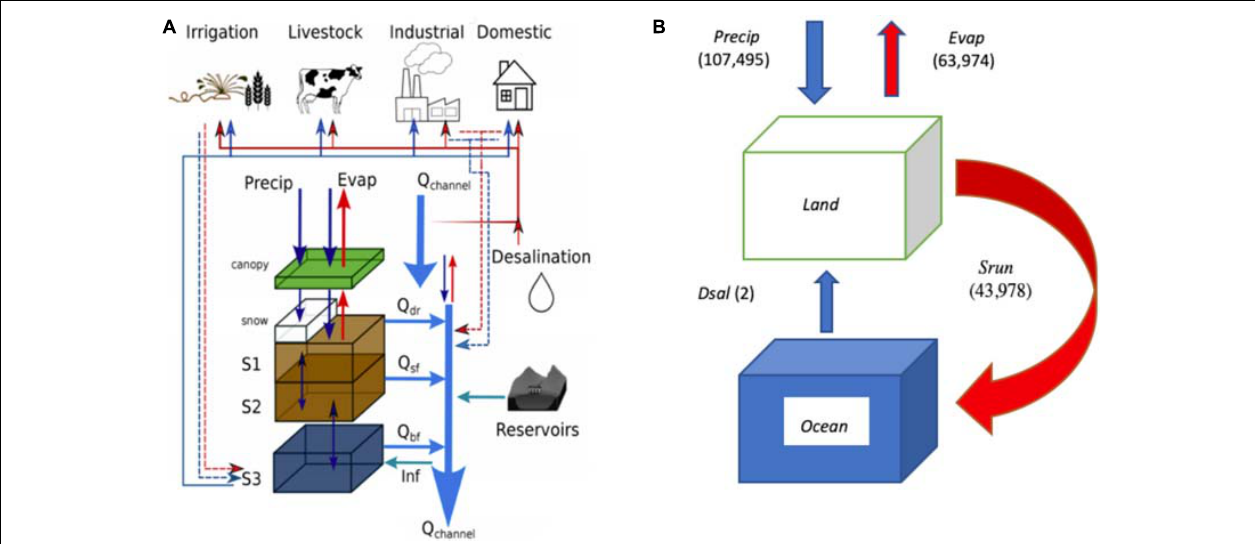
FIGURE 1 | (A) An overview of a PCR-GLOBWB 2 grid cell from Sutanudjaja et al. (2018). S1, S2 (soil moisture storage), S3 (groundwater storage), Qdr (surface runoff), Qsf (stormflow), Qbf (baseflow), and Inf (riverbed infiltration to groundwater). (B) Simplified sketch of LWS fluxes. Precip, Precipitation; Evap, Evaporation; Dsal, Desalinated Water; SRun, Runoff (adapted from Sutanudjaja et al., 2018). Fluxes ( km 3 yr − 1 ) shown in (B) indicate global annual mean values over the period 2000–2015.